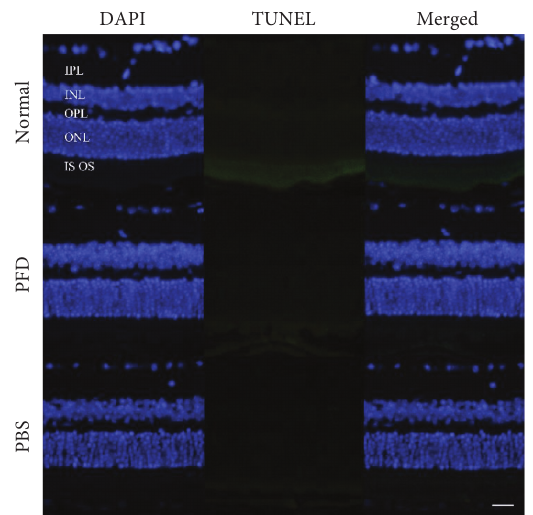
Figure 4: . Intravitreal injection of PFD does not cause apoptosis. TUNEL (green) and DAPI (blue) immunofluorescence staining of mouse choroid/RPE/retina cryosections from the normal: PBS and 0.5% PFD groups (IPL: inner plexiform layer; INL: inner nuclear layer; OPL: outer plexiform layer; ONL: outer nuclear layer; IS: inner segment; OS: outer segment). Scale bar: 200 μ